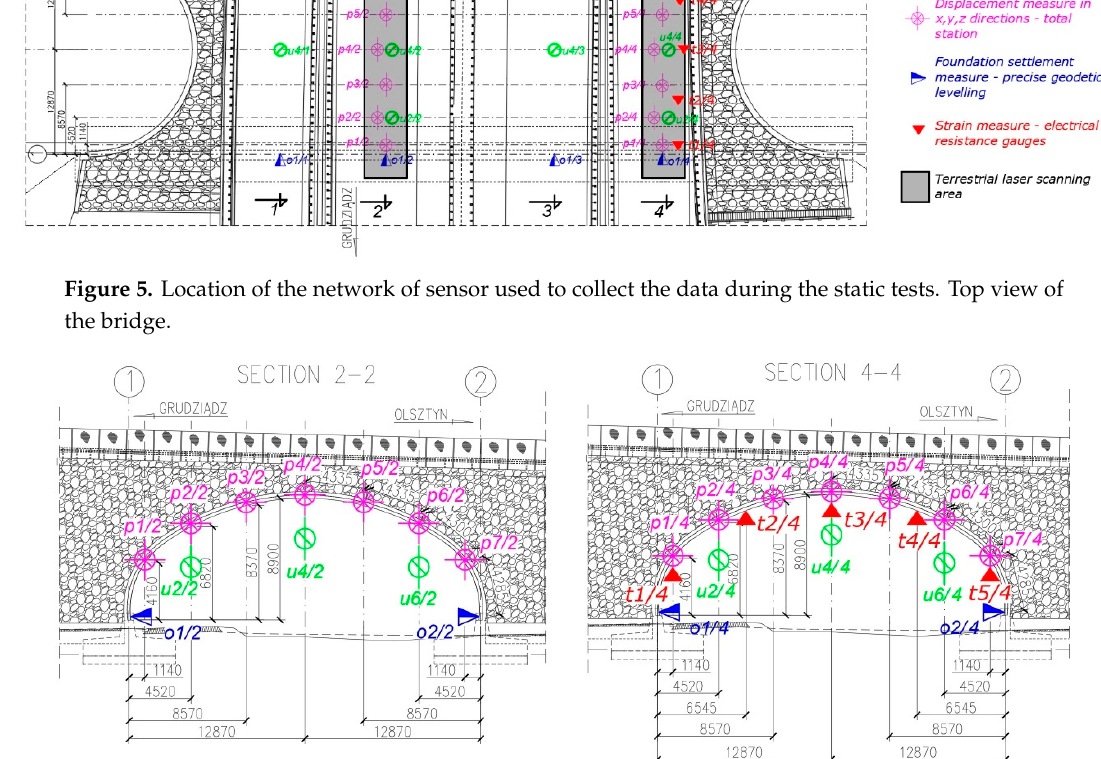
Figure 5. Location of the network of sensor used to collect the data during the static tests. Top view of the bridge.